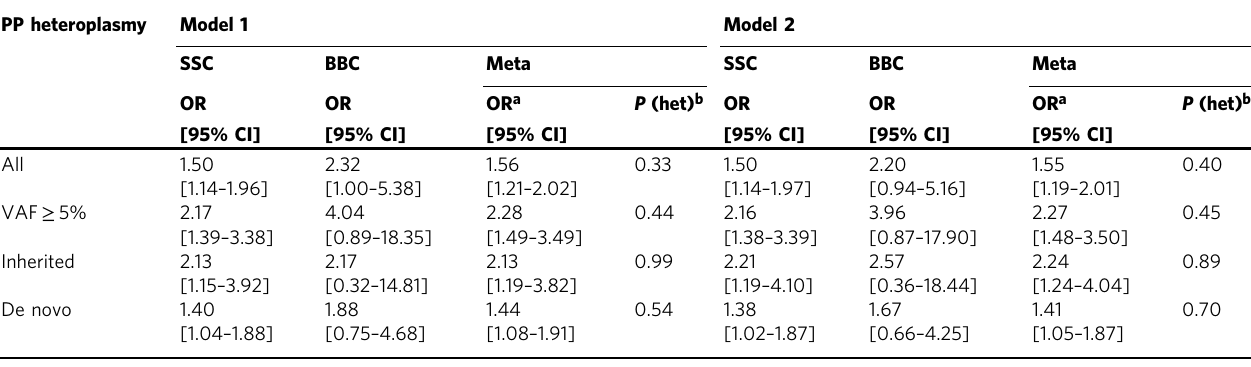
Model 1: SSC: ~ carrying PP heteroplasmies + mtCNz + strata(family id); BBC: ~ carrying PP heteroplasmies + mtCNz + sex + mtDNA-inferred ancestry; Model 2: SSC: model 1 + maternal age at childbirth + paternal age at childbirth + child age at the time of sample collection; BBC: model 1 + maternal age at childbirth. a The OR (odds ratio) of carrying predicted pathogenic (PP) heteroplasmies for ASD were estimated based on fi xed-effect meta-analysis(Meta) of the results from the SSC and BBC; the ORs of carrying inherited PP heteroplasmies and de novo PP heteroplasmies were assessed jointly as: ~ de novo heteroplasmy + inherited heteroplasmy + covariates. b Q statistic P values for heterogeneity in the ORs estimated between the SSC and BBC. The null distribution of Q statistic follows a chi-square distribution with 1 degree of